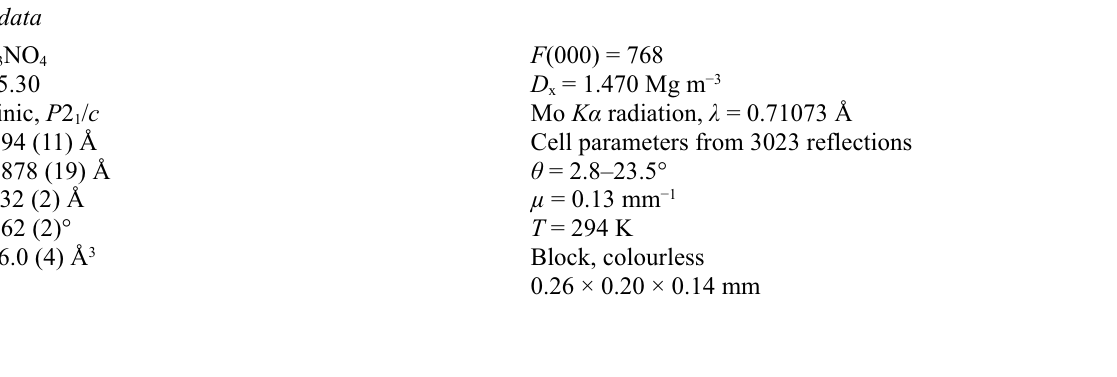
The crystal packing of (I). Intermolecular hydrogen bonds are shown as dashed lines. 5-(4-Fluorophenyl)-2-furylmethyl N -(2,6-difluorobenzoyl)carbamate Crystal